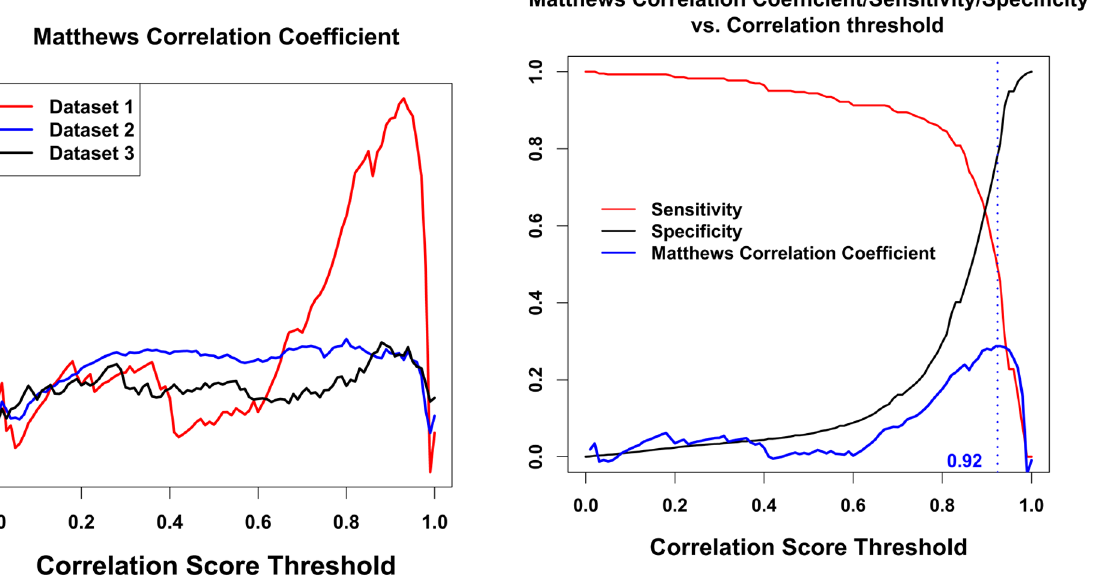
Figure 4. Matthews correlation coefficient (MCC) vs. choice of binary classification threshold for Datasets 1, 2, 3. It is seen that there is a much higher and more distinct peak for Dataset 1, supporting the inference derived from the relative AUC scores (Figures 1, 2, and 3) that the Dataset 1 provides the best differentiation between the interacting and non-interacting pairs.